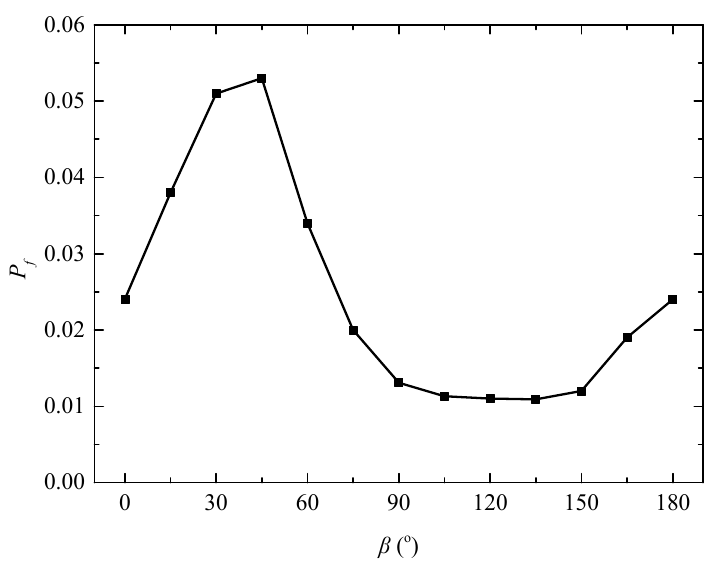
Figure 11. Failure probability with different random field rotation angles.